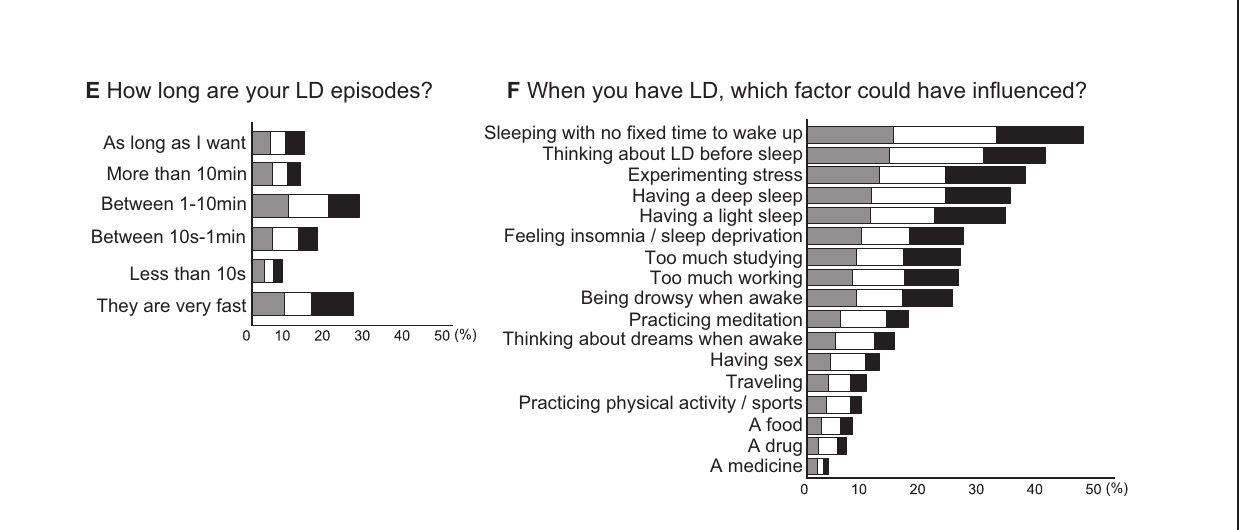
Frequency of LD control. ( D ) Things to do during LD. ( E ) LD episodes duration. ( F ) Factors that may have facilitated LD